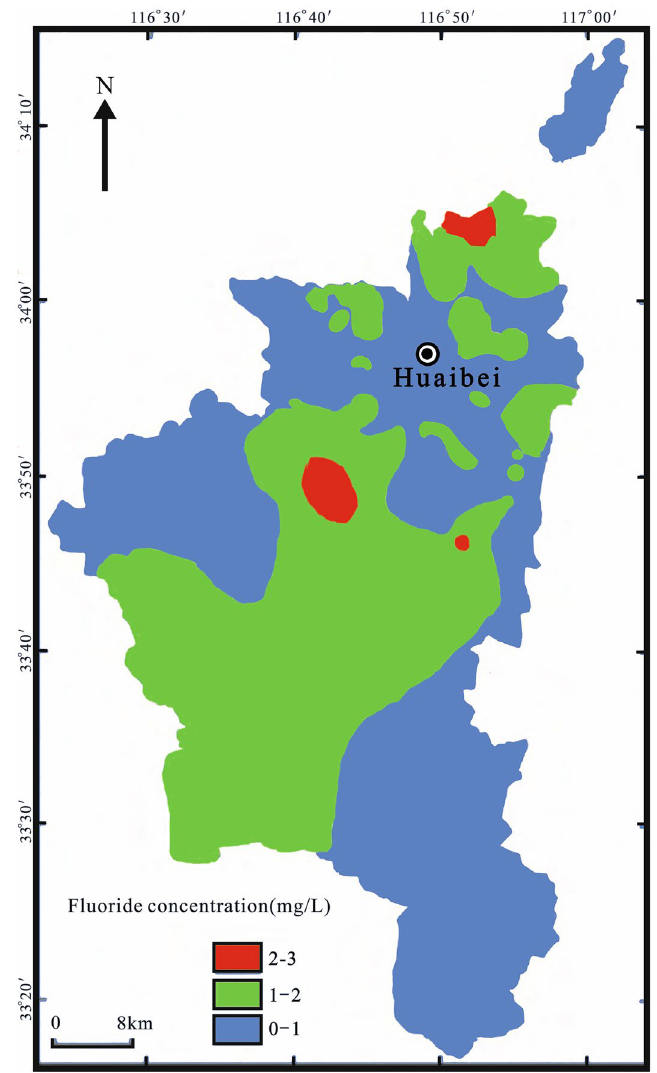
Figure 2. Map of fluoride concentrations in groundwater of study area (created with the software of ArcGIS desktop